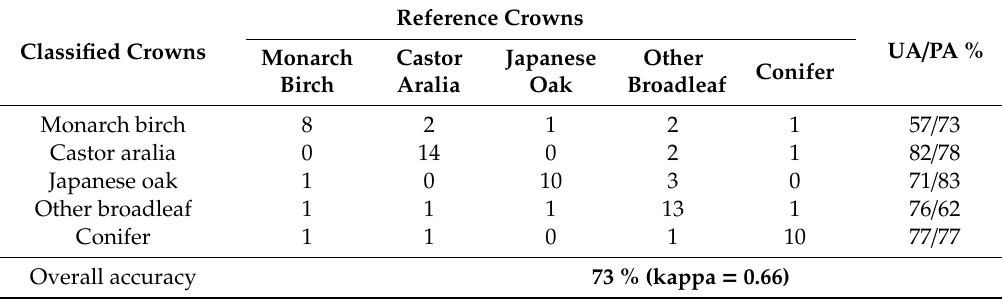
Table 5. Confusion matrix for the random forest (RF) classification of broadleaf species into high-value timber species and other broadleaf species based on 75 validation crowns from known tree positions in sub-compartment 36B.